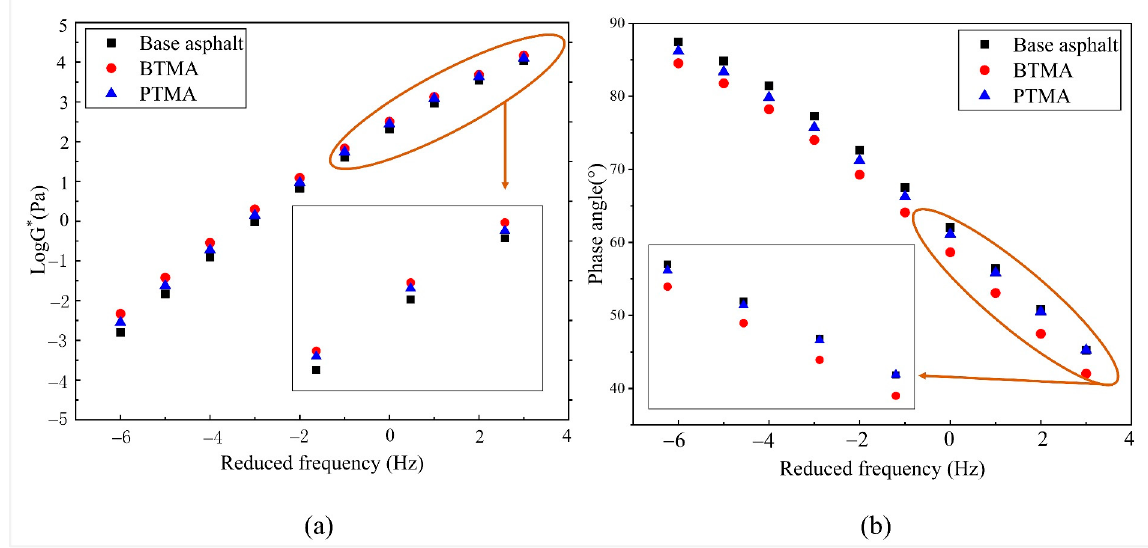
Figure 13. Frequency sweep for all binders at a reduced frequency: ( a ) complex modulus, ( b ) phase angle.